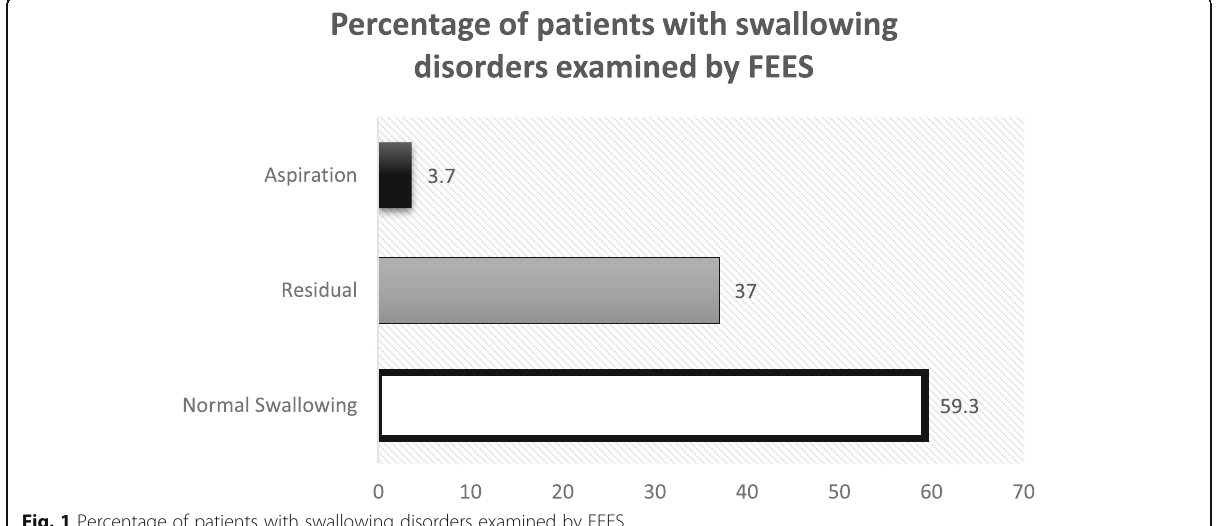
Fig. 1 Percentage of patients with swallowing disorders examined by